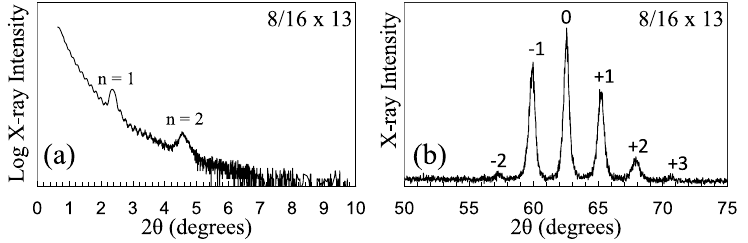
Figure 2. ( a ) XRR low − angle specular X − ray diffraction of the 8/16 × 13 Fe/V superlattice. Two superlattice satellites are observed at 2 θ = 5 ◦ . ( b ) High angle XRD of the same sample shows [200] single crystalline superlattice